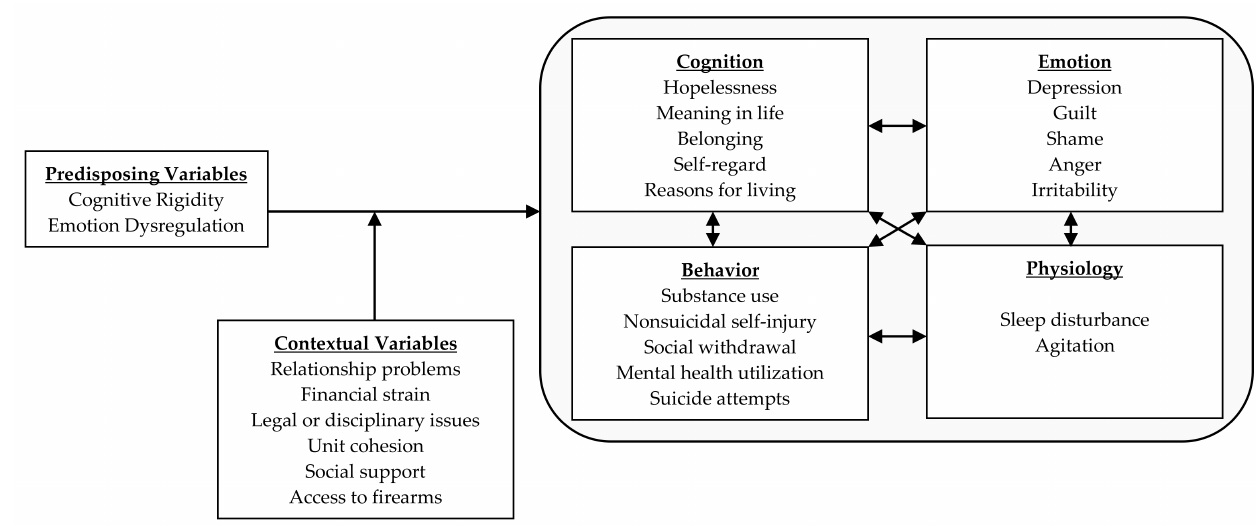
Figure 2. The Suicidal